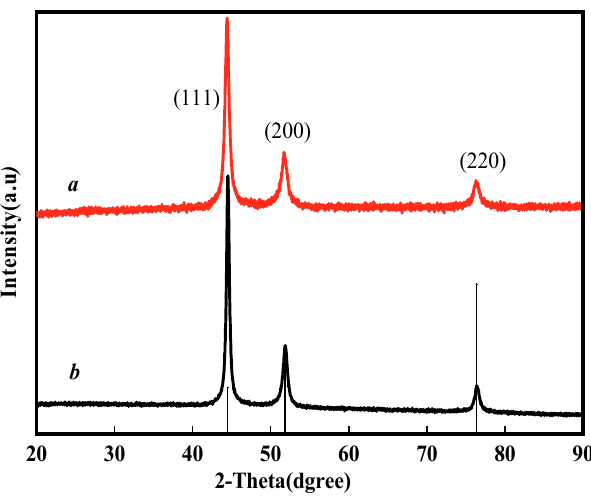
Figure 3. XRD patterns of HTPB/nNi (( a ) HTPB/nNi; ( b ) nNi).